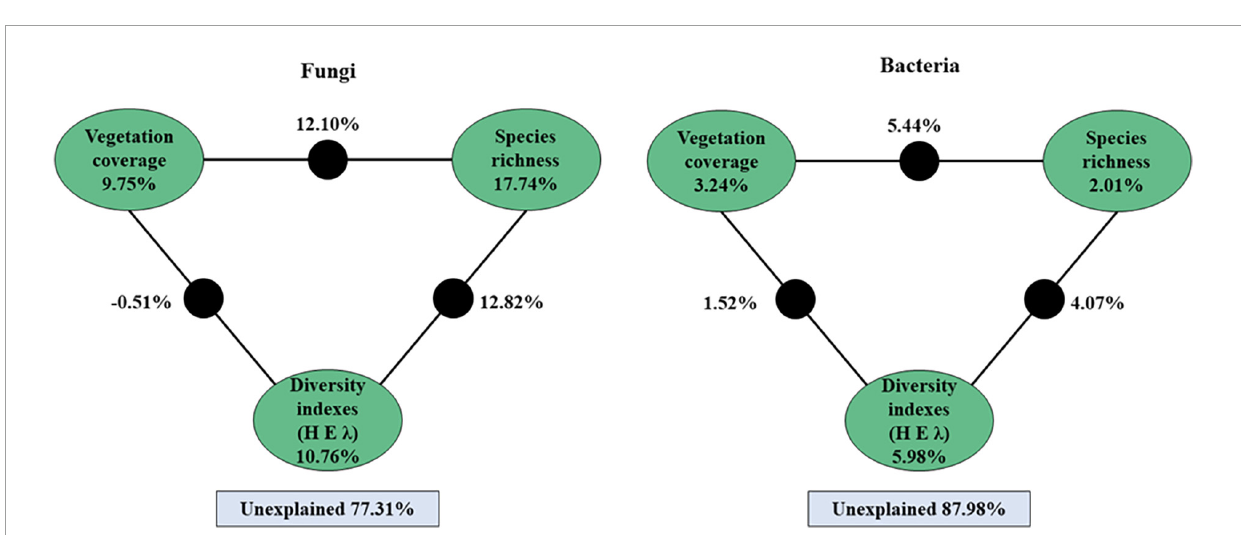
FIGURE7 Variation partitioning analysis (VPA) of the fungal and bacterial community explained by vegetation coverage, species richness and plant’s diversity indexes (H, E, and λ ) and their interactions. The value of black circle is the common explanation of the factors at both